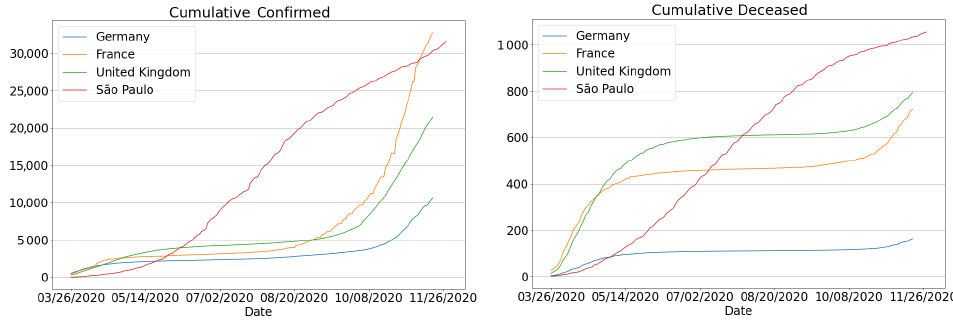
Figure 1. Comparison of cumulative number of cases and deaths per million: São Paulo state, France, Germany and United Kingdom. Country data are from Johns Hopkins University